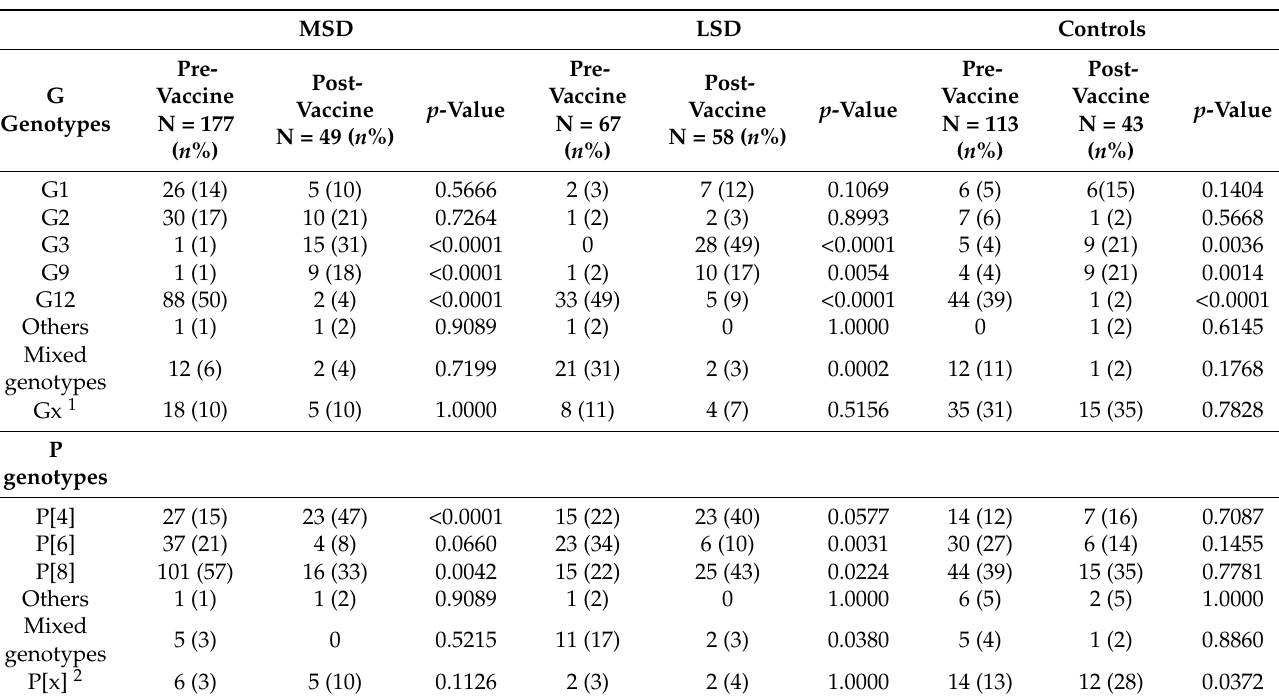
Table 2. Rotavirus single G, P and combined G-P genotypes found in cases of MSD, LSD and controls in children <5 years of age, in Manhiça (Maragra, Manhiça District Hospital, Taninga, Ilha Josina, Nwamatibjana, Malavele and Xinavane), Mozambique, 2008–2012 and